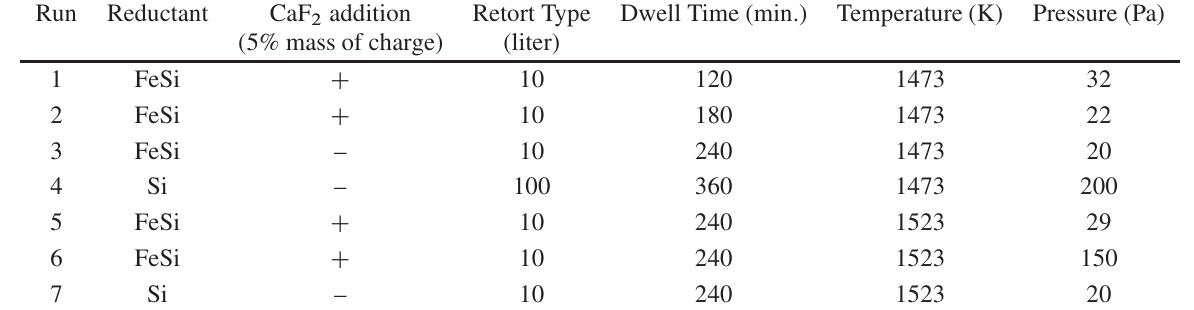
Table 1. Mixture content and experimental parameters.